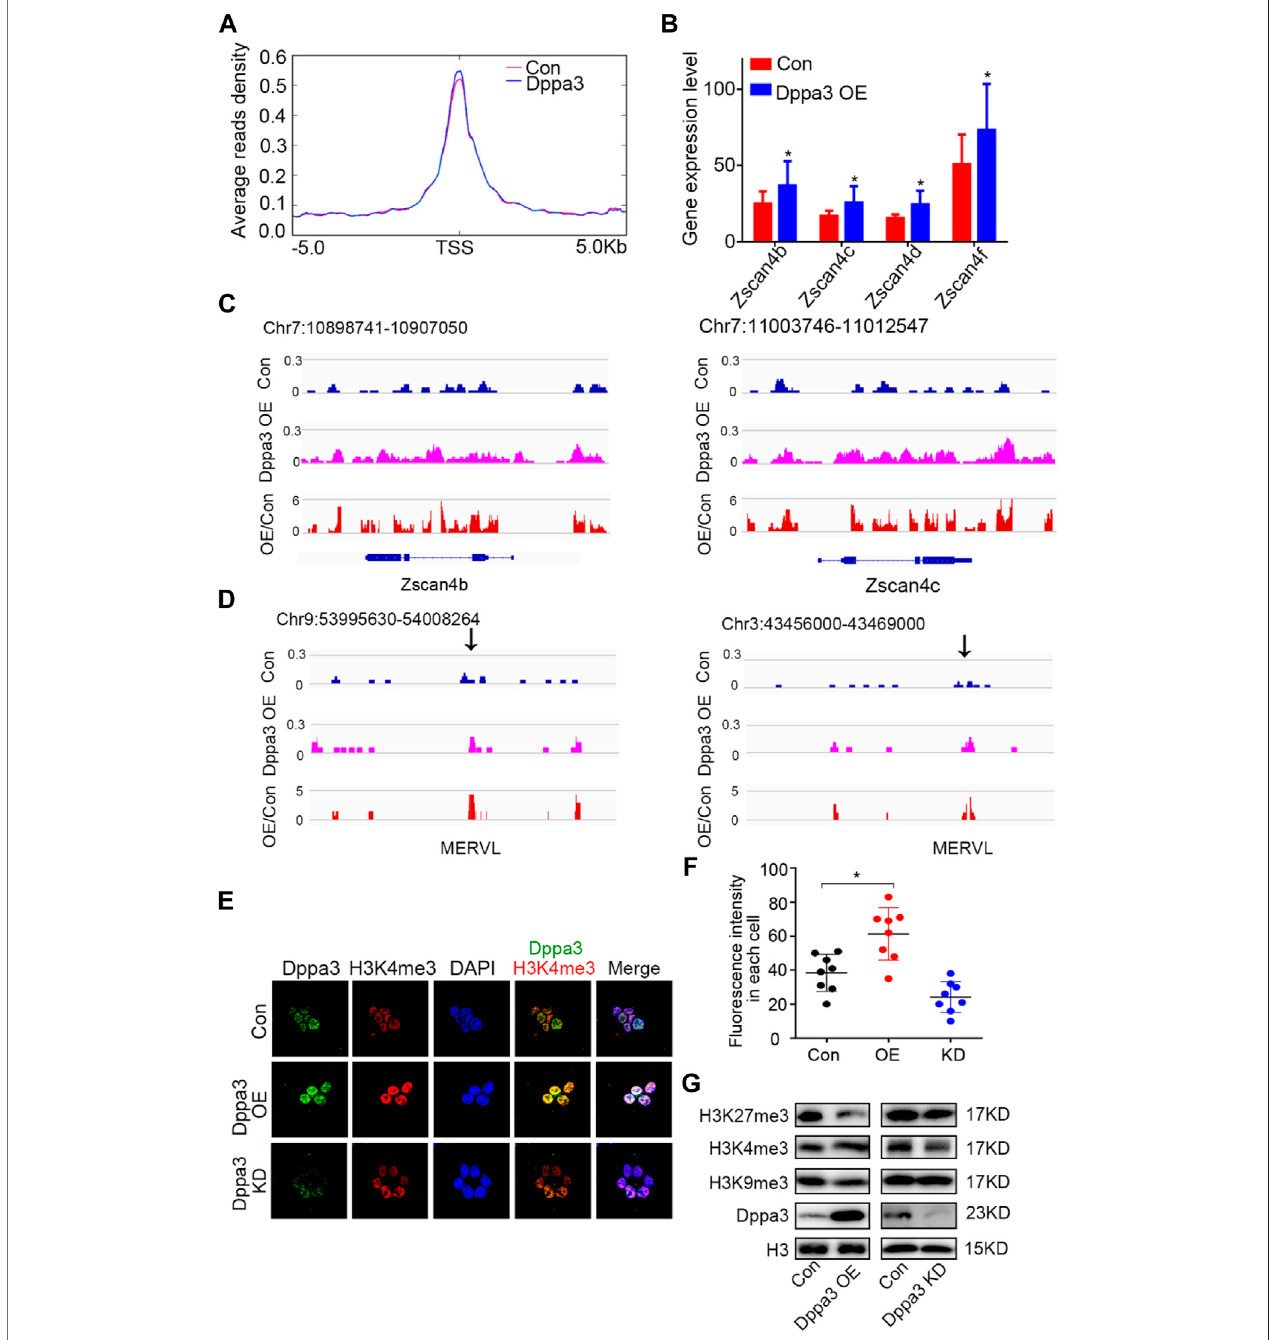
FIGURE5| Dppa3 facilitatesthechromatinconversiontoresemblingthatoftwo-cellembryos. (A) AveragedensityofATAC-SeqreadsaroundTSSs(±5 kb)forthe 2Crelated geneset.Thered linerepresentsthesignaldistributionofATAC in2C-speci fi cgenesset inCongroup,theblue linerepresentsthesignaldistributionofATAC in2C-speci fi cgenessetinthe Dppa3 OEgroup. (B) Expressionof Zscan4b , Zscan4c , Zscan4d ,and Zscan4f in Dppa3 OEESCscomparedtothoseinConESCs. (C,D) GenomebrowserviewofthedistributionofATAC-Seqsignalsatthe2C-relatedgenesin Dppa3 OEandConESCs.Shownare Zscan4 (atChr7) (C) and MERVL (at Chr3 and Chr9) (D) . (E) Immuno fl uorescence ofH3K4me3 (red) and Dppa3 (green) in Dppa3 OE, Dppa3 KD, and controlESCs. Scale bar = 10 μ m. (F) Quanti fi cation of numbers of H3K4me3 foci in Dppa3 OE and Con ES cells (n = 4; * p < 0.05; each dot represents the fl uorescence intensity in each cell in one replicate experiment). (G) Western blot analysis of histone modi fi cations in Dppa3 OE, Dppa3 KD, and control ESCs.